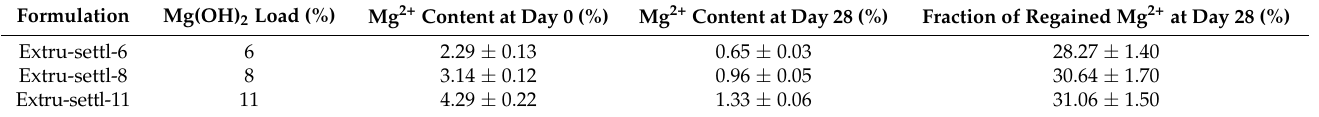
Table 3. Mg 2+ content of the microspheres of the present study by ICP-AES (means ± SD, n = 3).